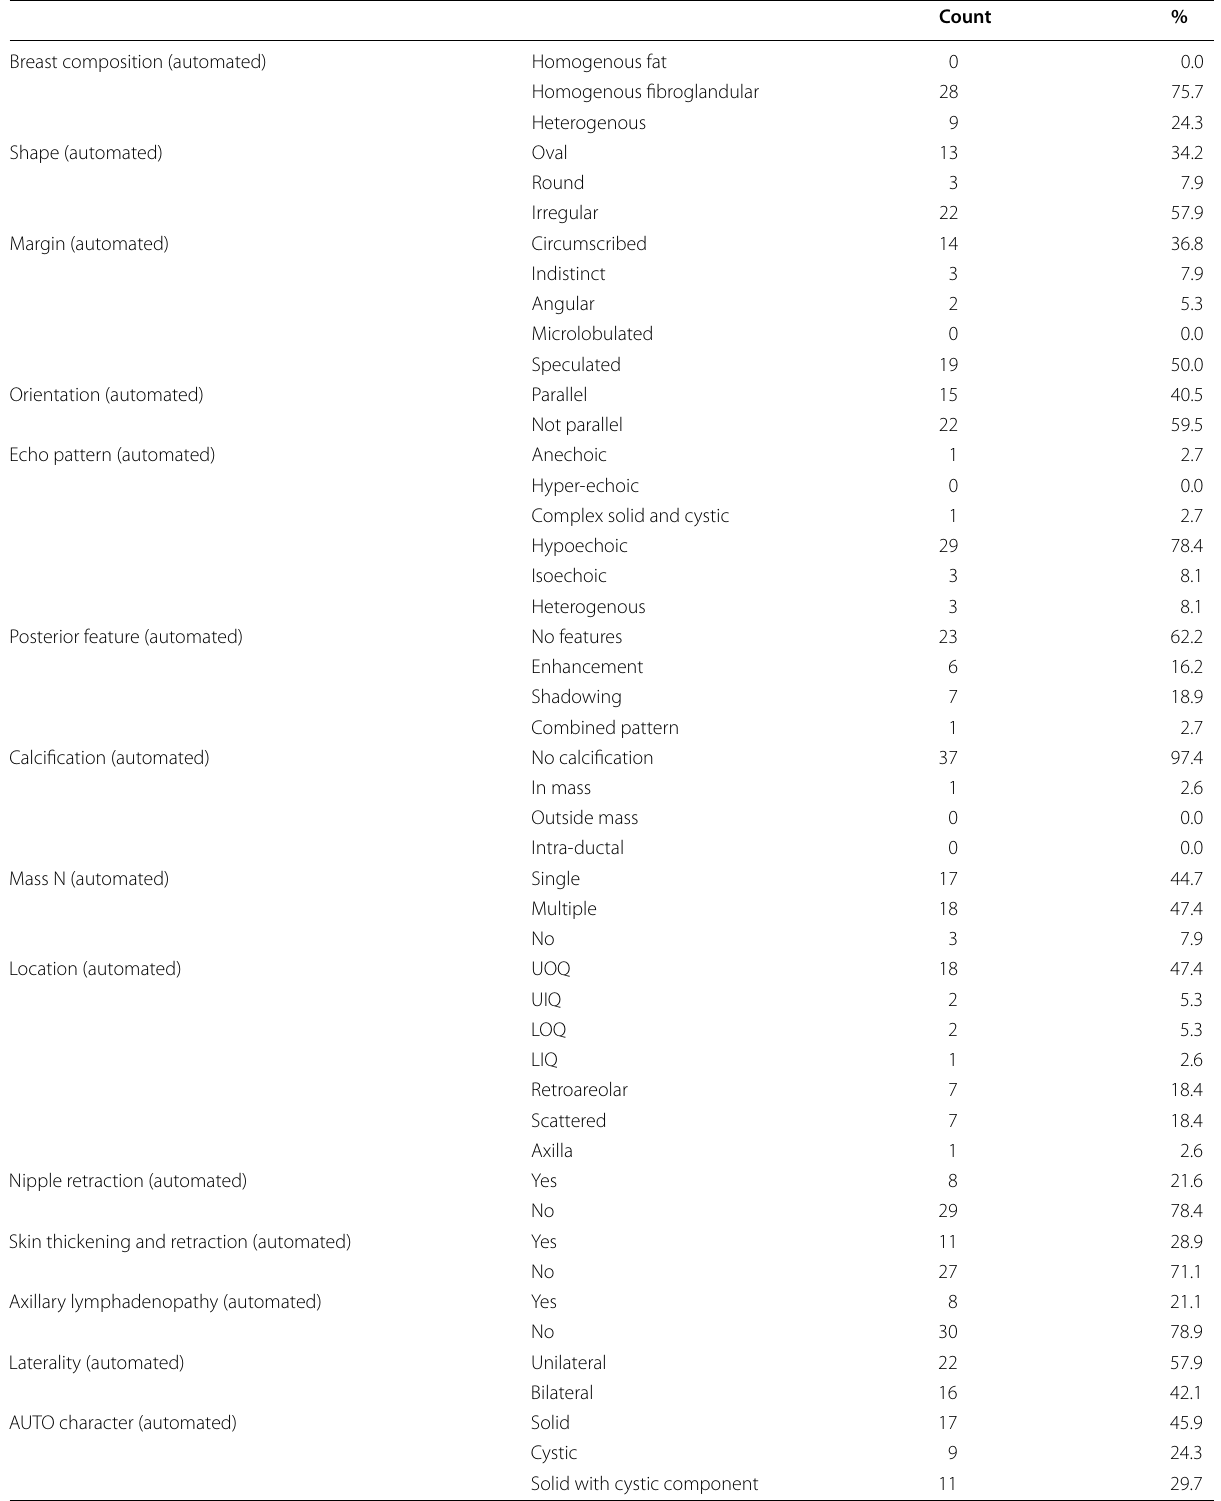
Table 6 Characterizations of the lesions